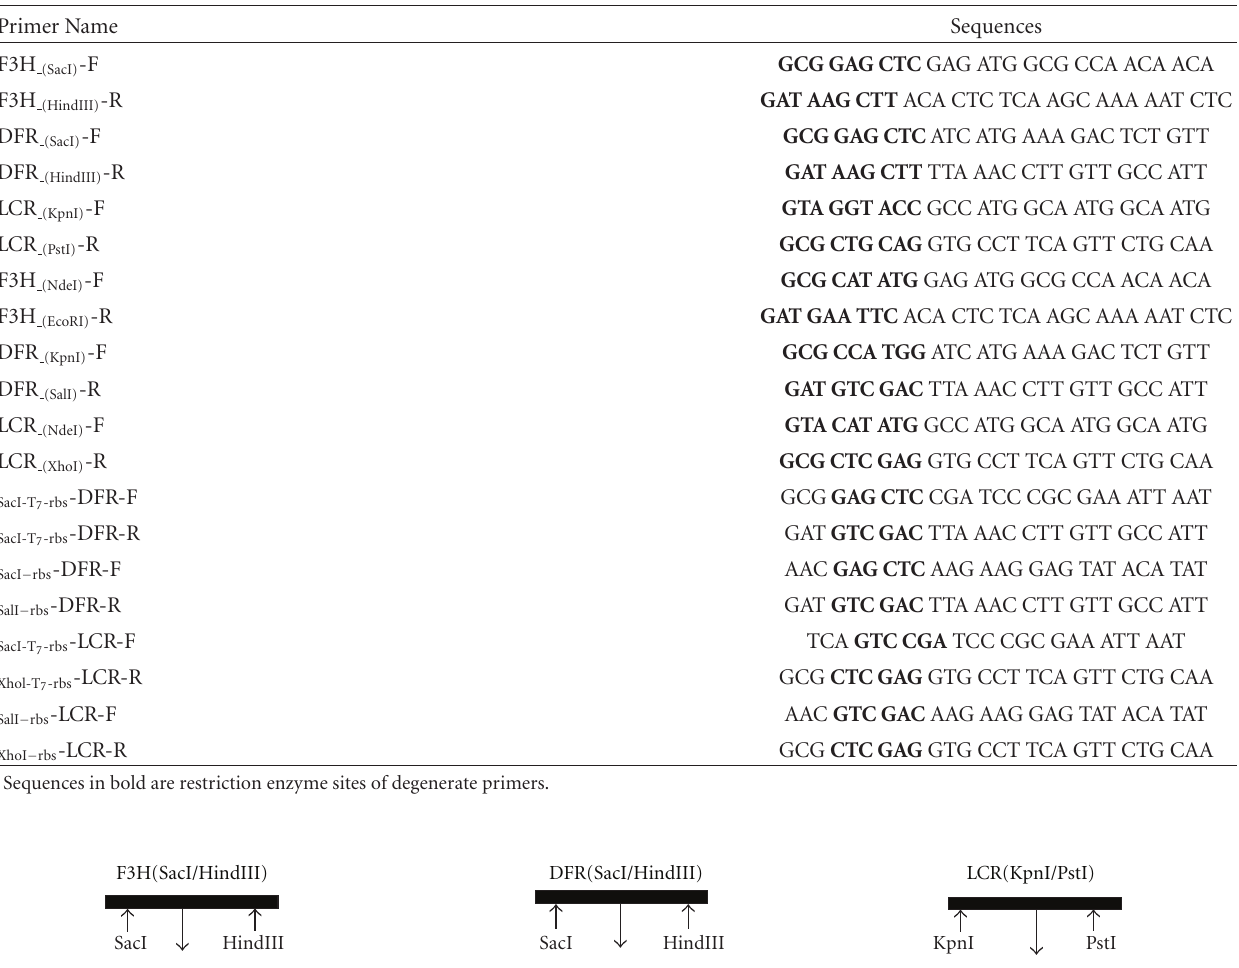
Table 1: Primers used for the study.